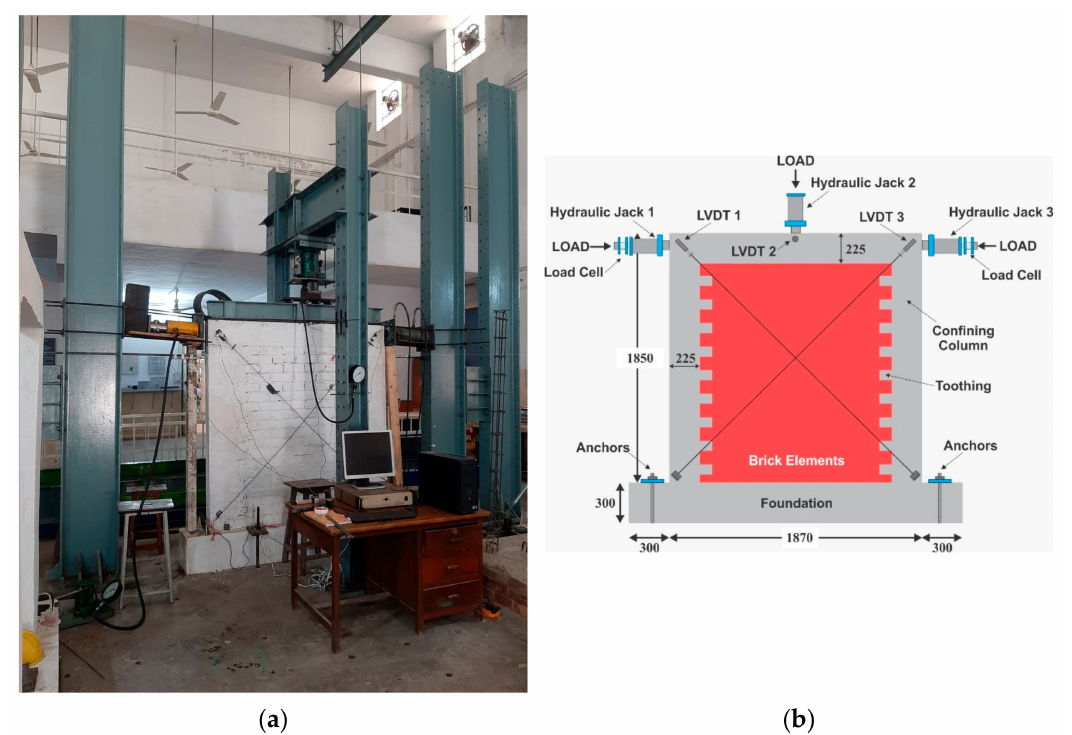
Figure 2. Experimental test setup ( a ) Actual, ( b ) Schematic.